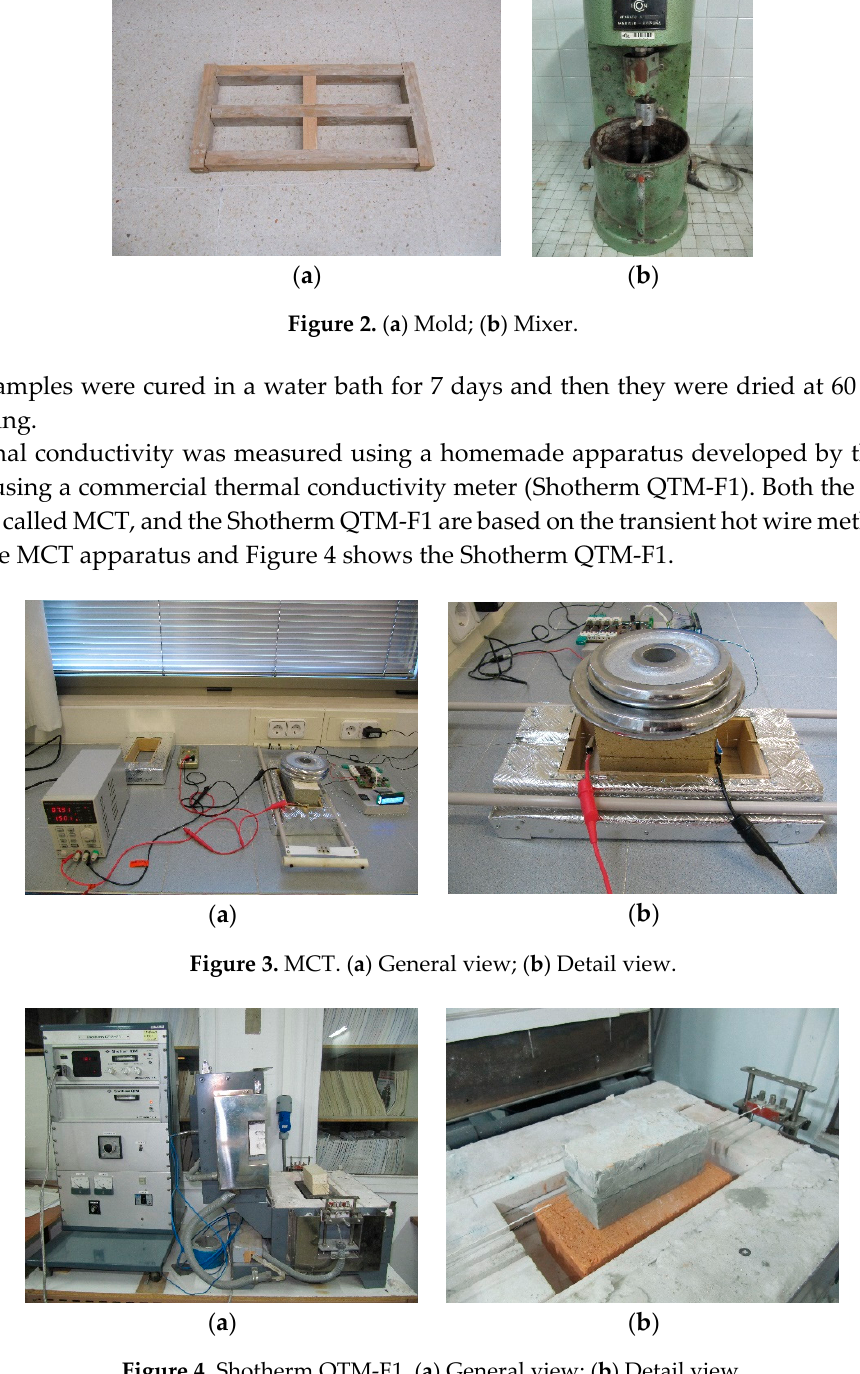
Figure 4. Shotherm QTM-F1. ( a ) General view; ( b ) Detail